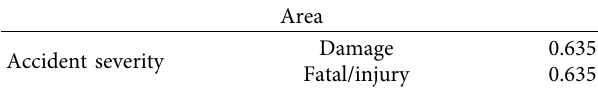
Table 16: The area under the curve for the RBFNN model.